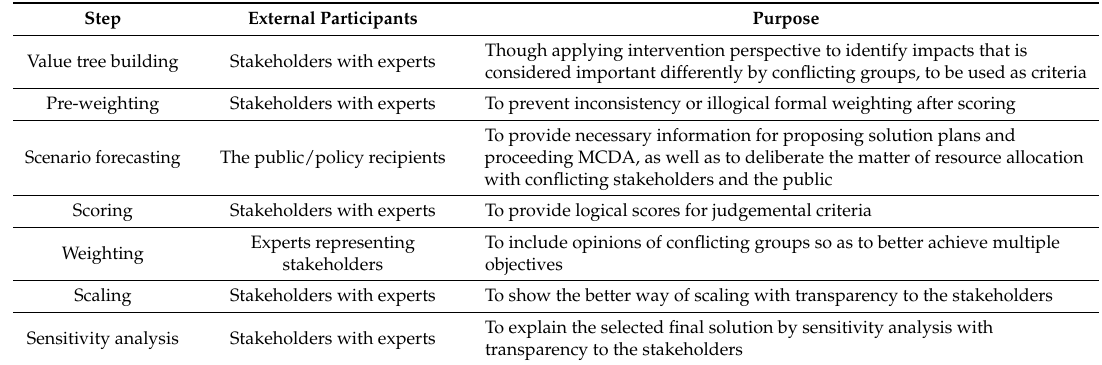
Table 2. The summary of participatory